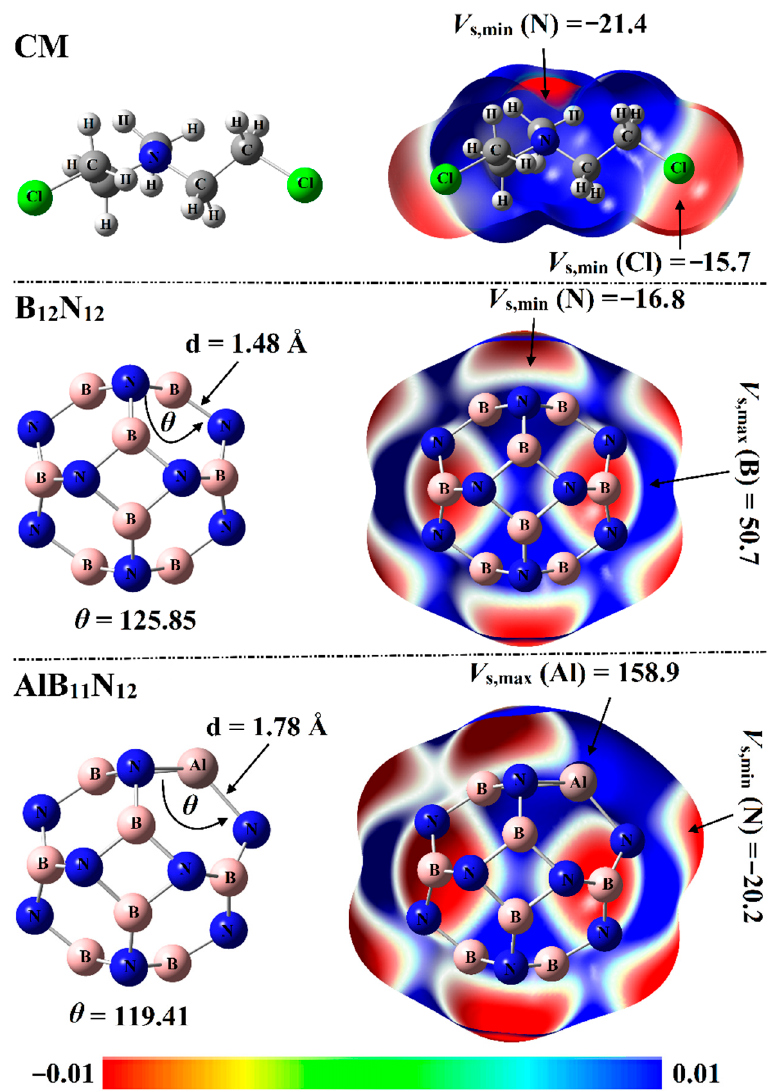
Figure 2. Optimized structures and molecular electrostatic potential (MEP) maps supplemented with electrostatic potential extrema ( V s,min / V s,max , in kcal/mol) of CM, B 12 N 12 , and AlB 11 N 12 . The color scale changes from red ( − 0.01) to blue (+0.01) au.